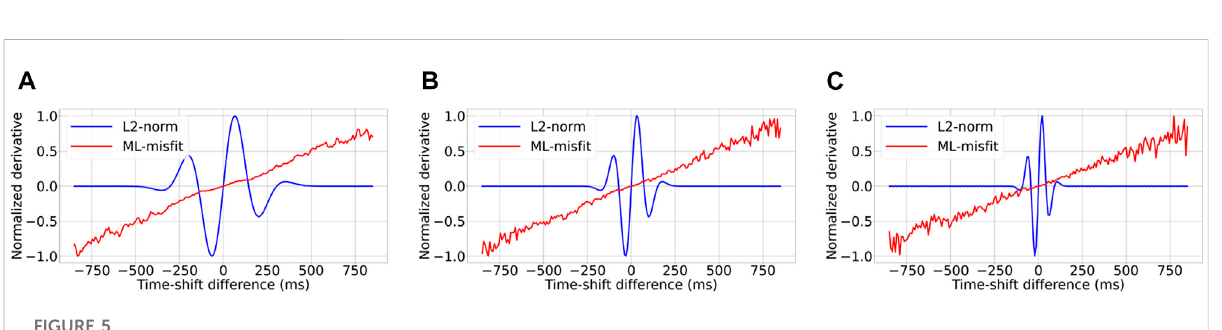
FIGURE 5 Derivatives ofthe L2norm and theML-mis fi tfunctions with respect to travel-time shiftsfor data with main frequency (A) 3 Hz, (B) 6 Hz, and (C) 10 Hz.